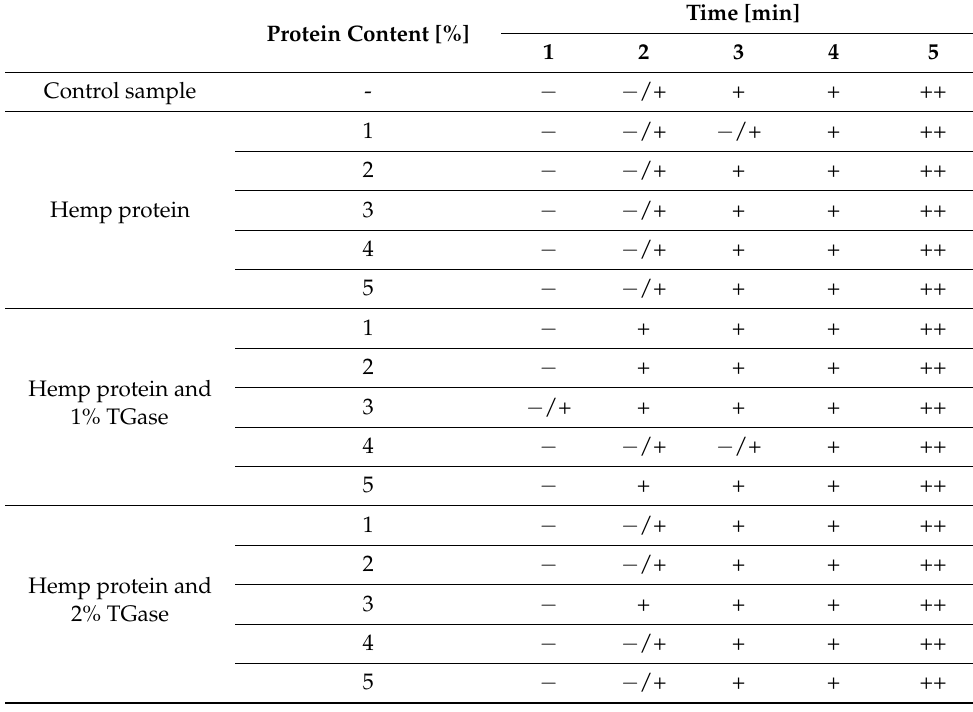
Table 2. Hydration times of instant noodles with the addition of hemp protein, hemp protein and TGase (the meaning of symbols used for evaluation is as follows: “ − ”-hard instant noodle, “ − /+”-semi-soft instant noodle, “+”-soft instant noodle, “++”-very soft instant noodle). Time [min] Protein Content [%] 1 2